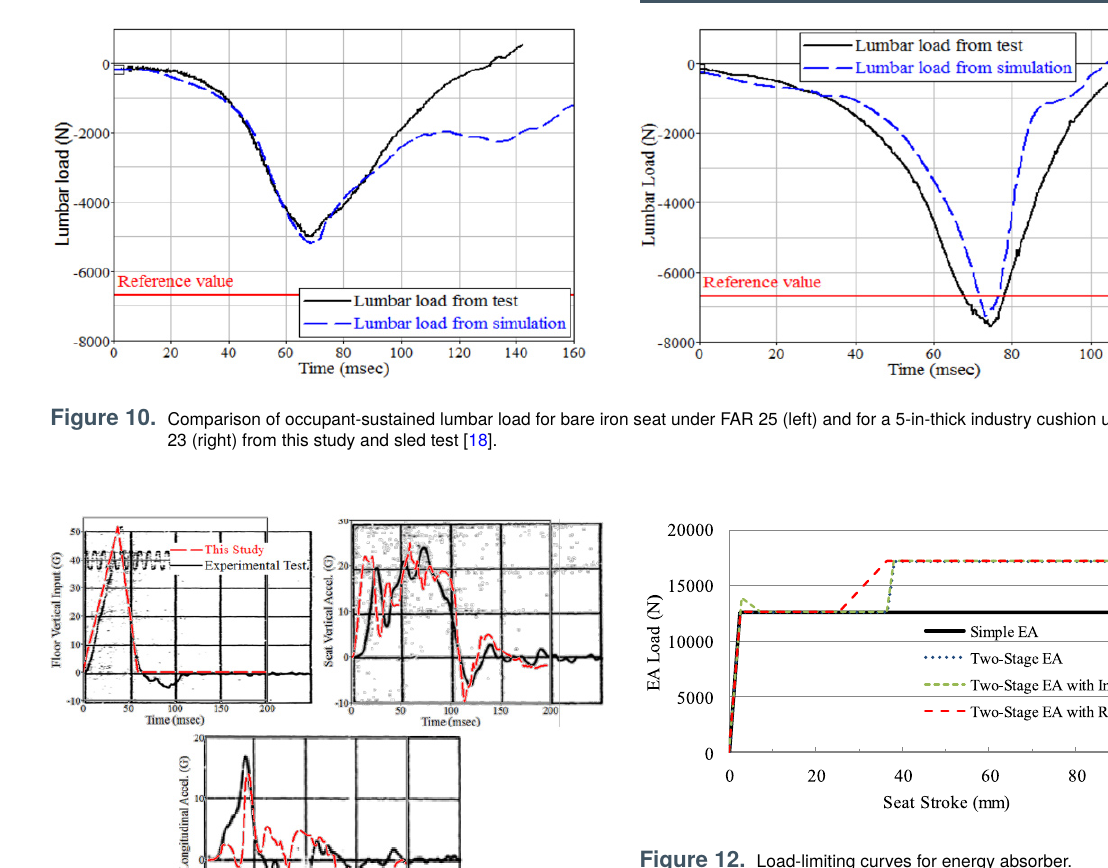
Figure 12. Load-limiting curves for energy